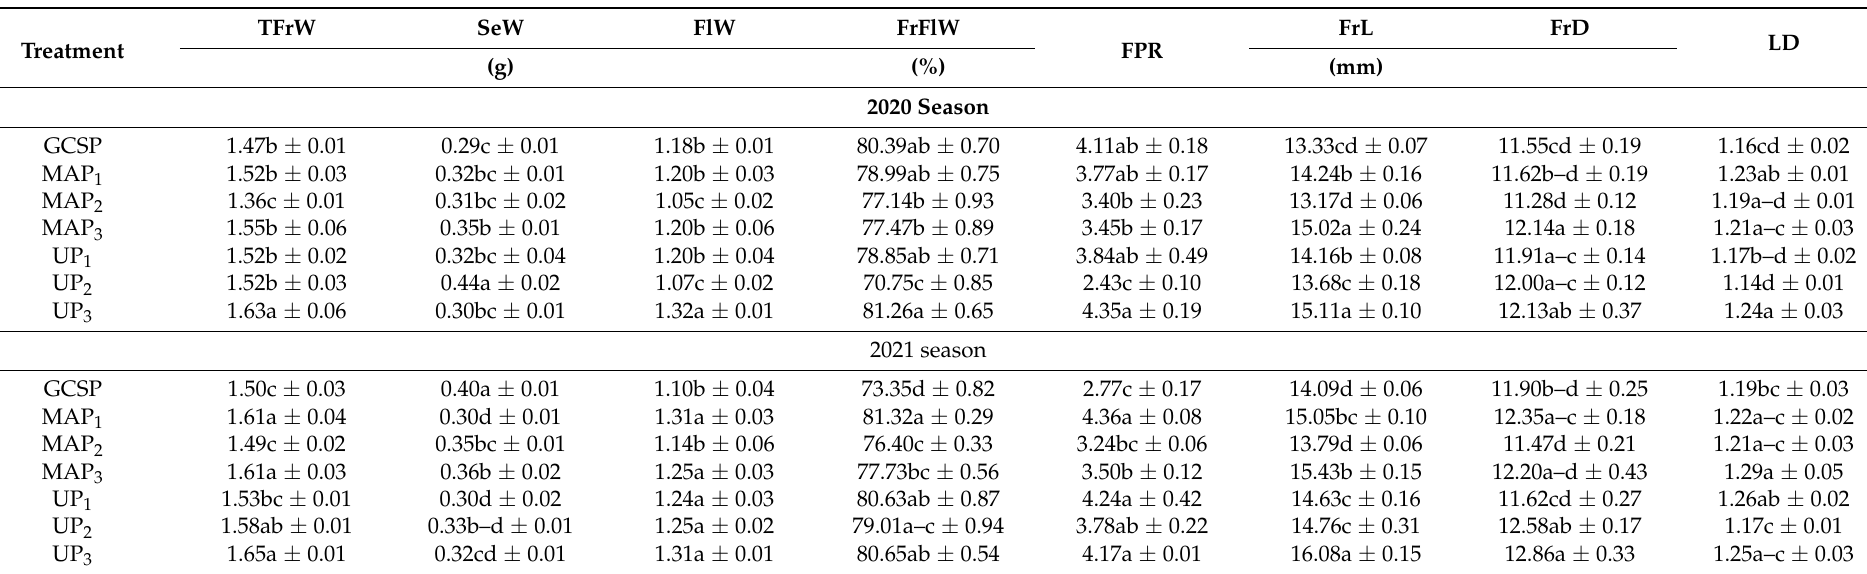
Table 7. Influence of different levels of MAP and UP in comparison with the recommended GCSP level on some fruit quality of olive ( Olea europaea L. arbequina cv.) trees grown in sandy loam clay soil under multi-abiotic stresses (CaCO 3 = 8.8 vs. 9.2%, ECe = 6.4 vs. 7.2 dS m − 1 , and pH = 7.78 vs. 7.89) during 2020 and 2021